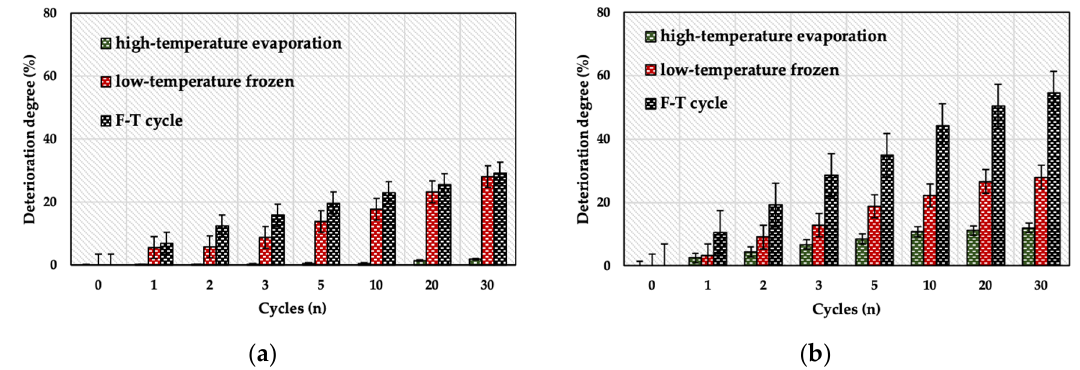
Figure 7. Deterioration degree of 70# asphalt and 70# foamed asphalt after with F–T cycles: ( a ) 70# asphalt and ( b ) 70# foamed asphalt.